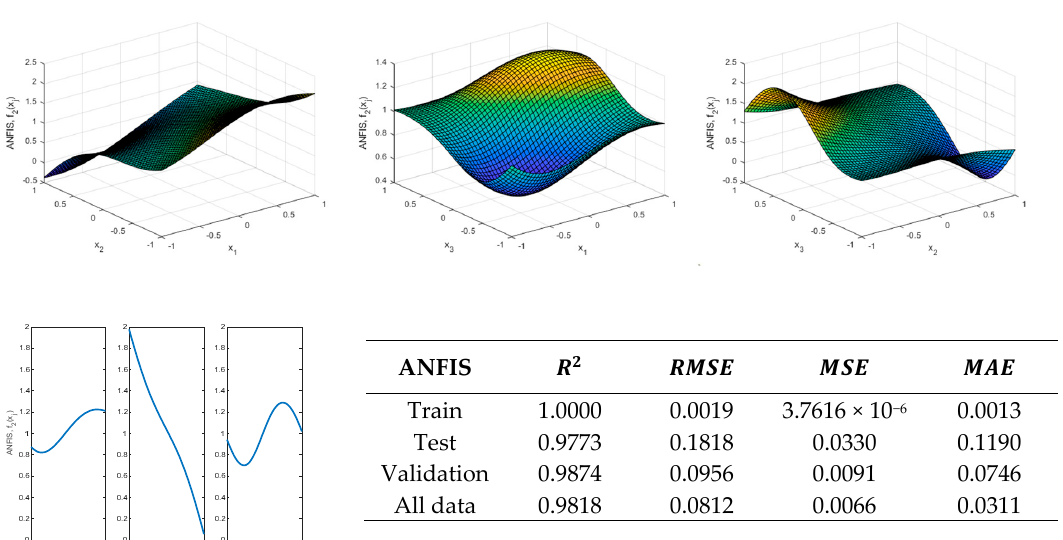
Figure 30. Response surface obtained with the zero-order Sugeno FIS employed for modeling f 2 using four Gaussian membership functions for the inputs and the proposed method for tuning the FIS using an ANFIS (Number of Epochs = 46, k FIS = 0.87, N FIS = 1.66 ).